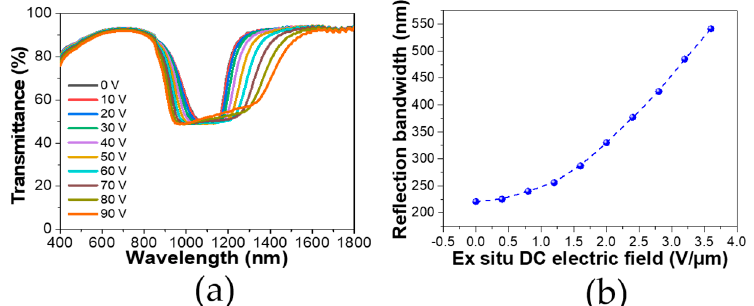
Figure 6. ( a ) Transmittance spectra of PSCLC cell under different ex situ DC electric fields. A PSCLC cell treated with an in situ DC electric field of 2.4 V/µm was chosen for the application of an ex situ DC electric field. ( b ) Reflection bandwidth of the cell under different ex situ DC electric fields.